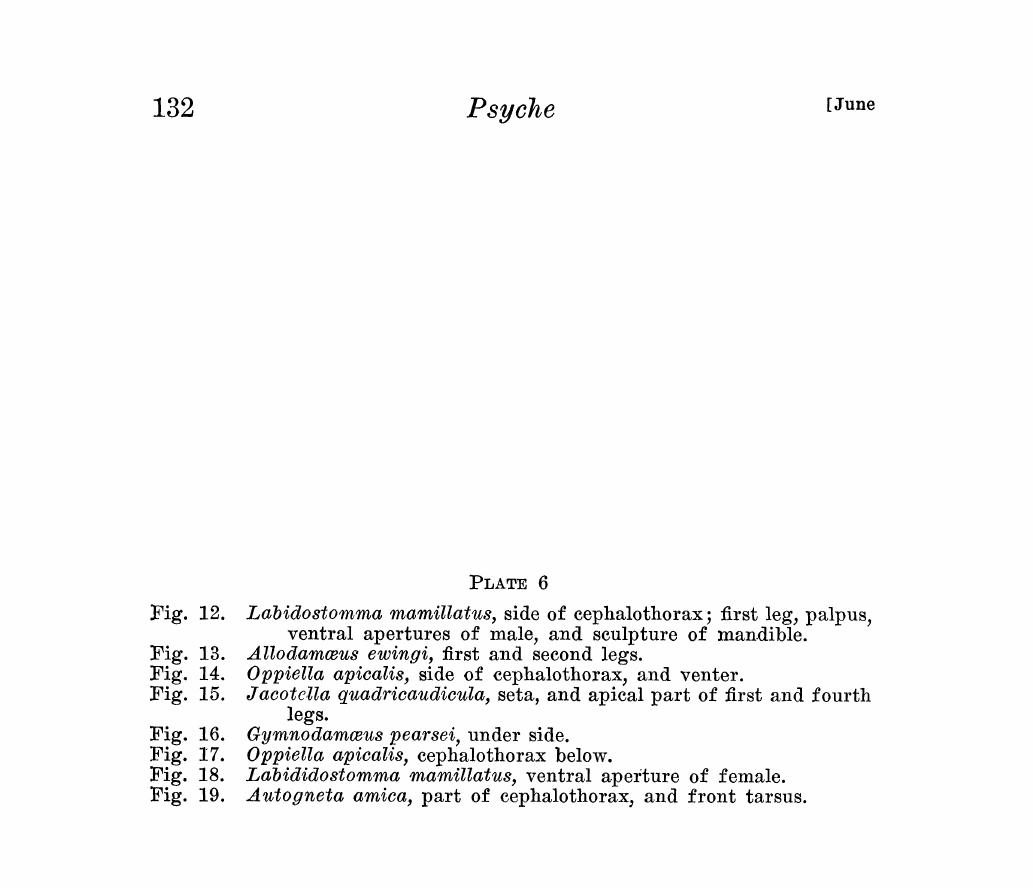
Fig. 12. Fig. 13. Fig. 14. Fig. 15. Fig. 16. Fig. 17. Fig. 18. Fig. 19.